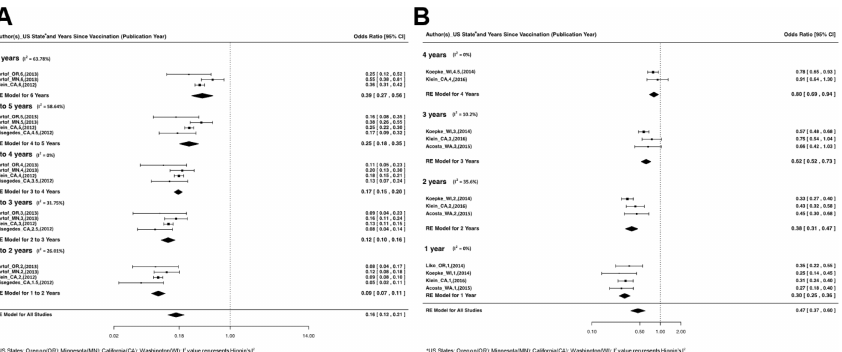
Fig 1. Meta-analysis of acellular pertussis vaccines. This figure represents the relative risk (OR) of pertussis infection occurring at different time points after vaccination. The I2 values (i.e. Higgin’s I2) quantifies the proportion of heterogeneity and dispersion in the meta-analytic model. Panel A: Represents a Meta-analysis of the OR of pertussis infection when comparing children immunized with the primary acellular pertussis series (5-dose DTaP) compared to vaccine naïve children. These OR values in Panel A were the product of a mathematical transformation of relative (5-dose DTaP) OR values. Panel B: Represents a meta-analysis of the OR of pertussis infection when comparing children immunized with the full acellular pertussis series (5-dose DTaP and 1-dose Tdap) compared to children immunized with only the primary acellular pertussis series.